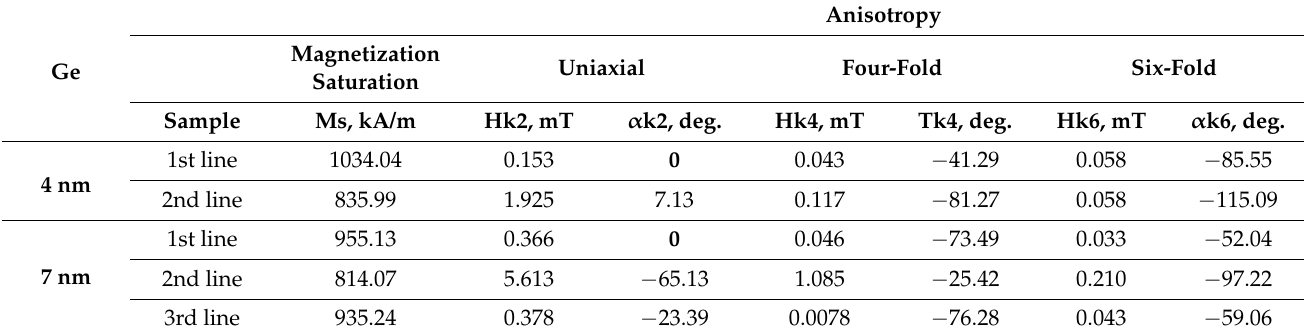
Table 4. Parameters of FMR lines and contributions of anisotropy of three-layer structures.